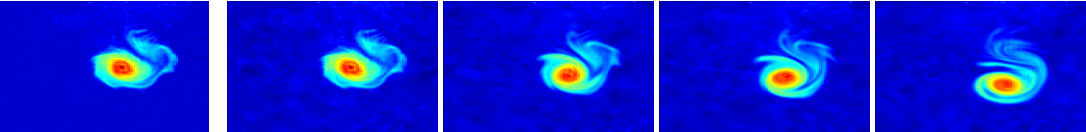
Figure 5. “True” initial concentration of the passive tracer ( 1st left ) and noisy observations at initial time ( 2nd ), after 90 min ( 3rd ), 150 min ( 4th ) and 270 min ( right ). The observations are then obtained by adding an observation error y = y t + (cid:101) , with (cid:101) ∼ N ( 0, R ) and R a suitably chosen matrix.